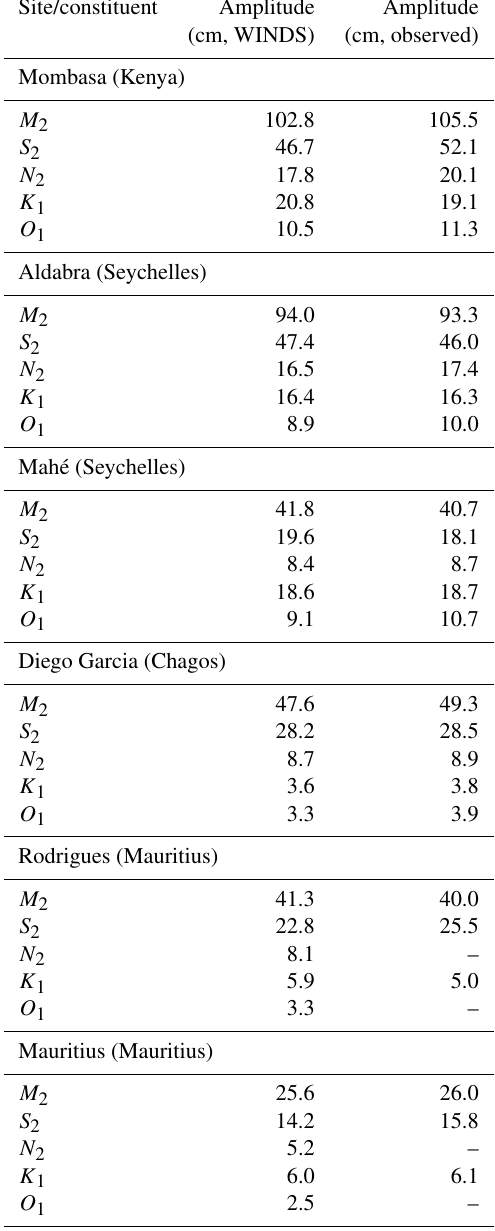
Table 1. Observational sources: Pugh (1979) (Mombasa, Aldabra, and Mahé); Lowry et al. (2008) (Rodrigues and Mauritius); Dunne (2021) (Diego